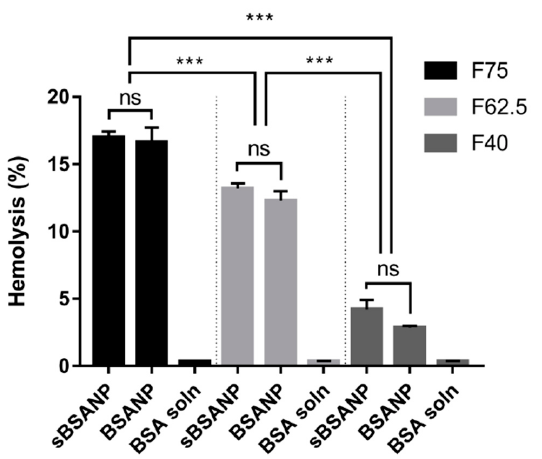
Figure 5. Hemolysis of erythrocytes induced by sBSANP and BSANP formulations at different BSA concentrations. *** p < 0.001 was considered statistically significant.